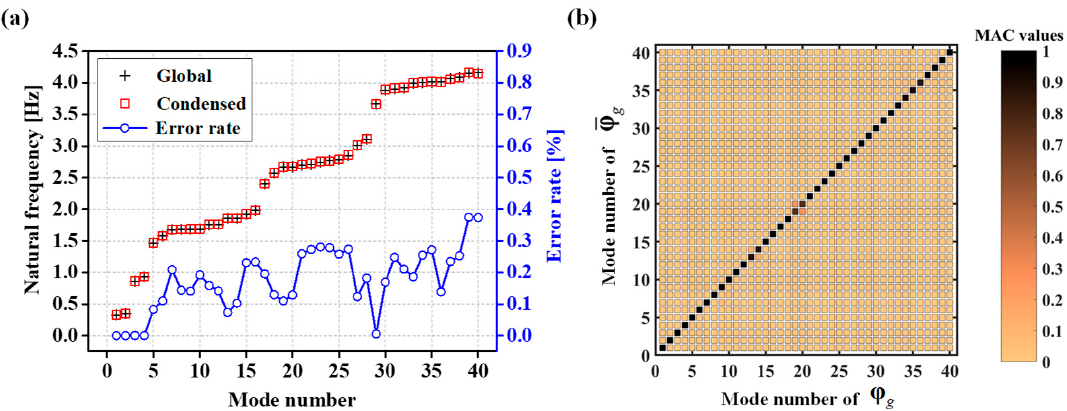
Figure 6. Modal analysis results: ( a ) Natural frequencies and error rates, ( b ) MAC values. Figure 7 shows the 1st–4th mode shapes of the stiffened FE model. Table 1 lists the natural frequencies, MAC values, and error rates for the 10 modes with the largest error. The maximum error rate was only 0.361% at the 39th mode.